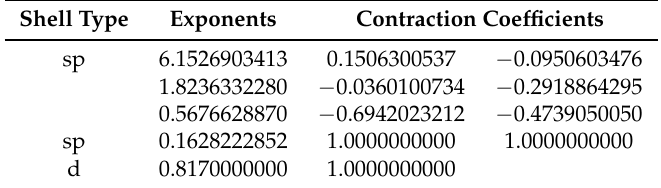
Table A8. Parameters of the cc-DZVP basis set of Nitrogen. Parameters taken from